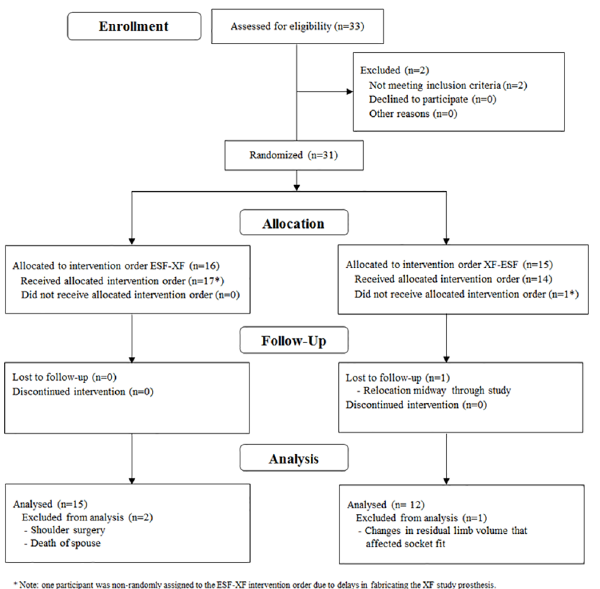
Fig 4. CONSORT participant flow